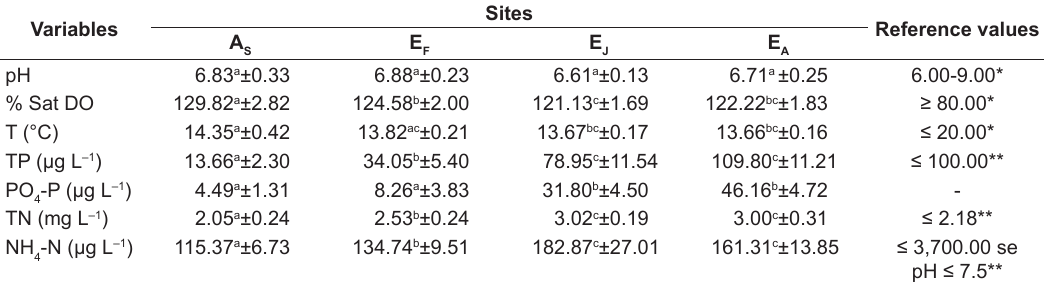
Table 1. Mean and confidence interval (95%) of the analyzed variables throughout the day (24 hours) in the trout farming system. Variables